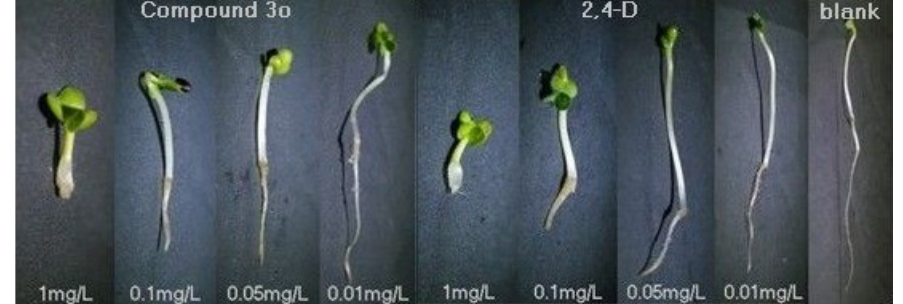
Figure 1. Photographs showing the lateral root development of dicotyledon rape at different concentrations of 3o (the first four specimens), 2,4-D (the second four specimens), and the control (the last specimen), respectively. Photographs were taken after 7 days